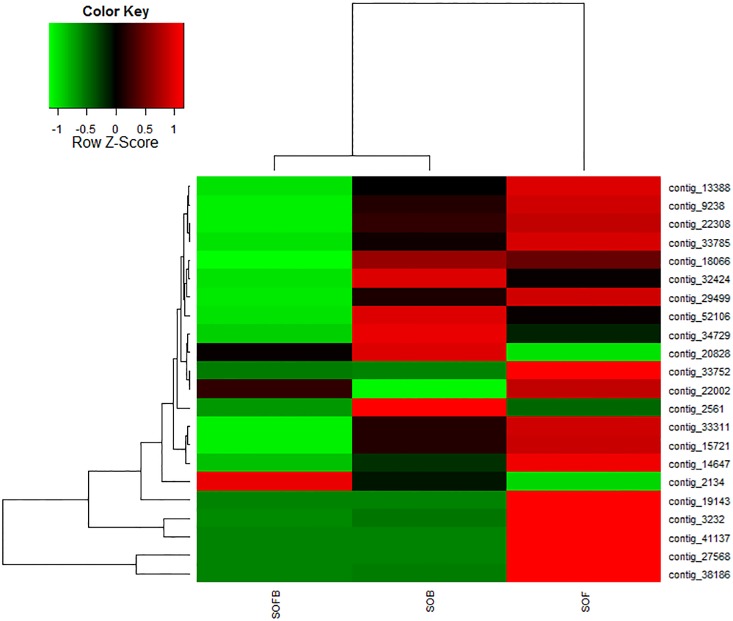
Differential expression of genes related to flower pigmentation and floral scent biosynthesis in Syringa oblata.Each column represents an experimental sample (SOFB, SOB, and SOF), and each row presents a gene. Expression differences are shown by different colors. Red indicates high expression and green indicates low expression.